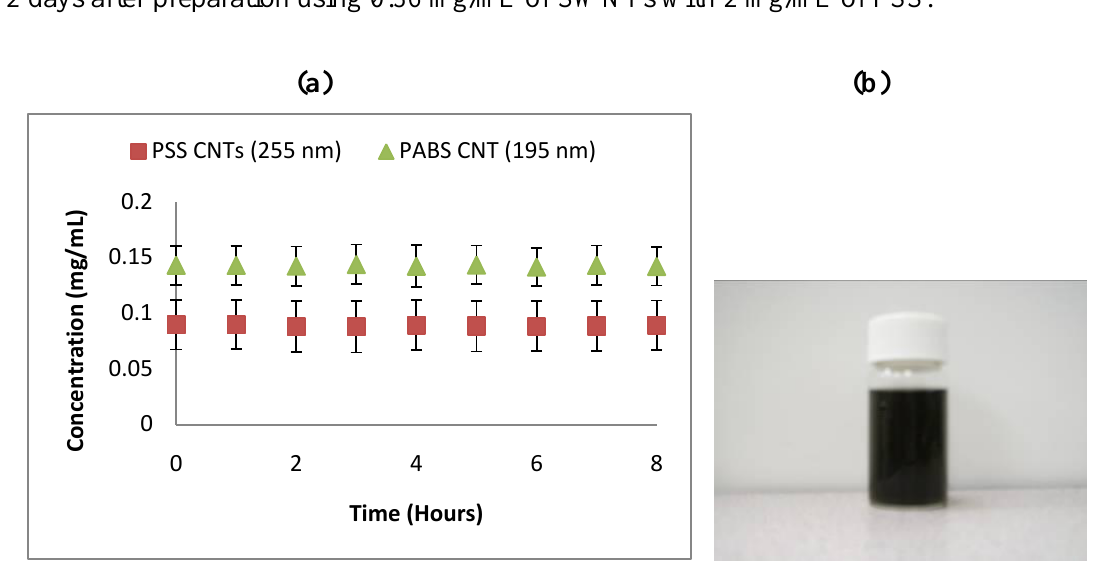
Figure 7. (a) Concentration vs. time profiles for PSS-SWNT and commercially available PABS-CNT suspensions over an 8 hour period; (b) at inset, PSS-SWNT suspensions 2 days after preparation using 0.36 mg/mL of SWNTs with 2 mg/mL of